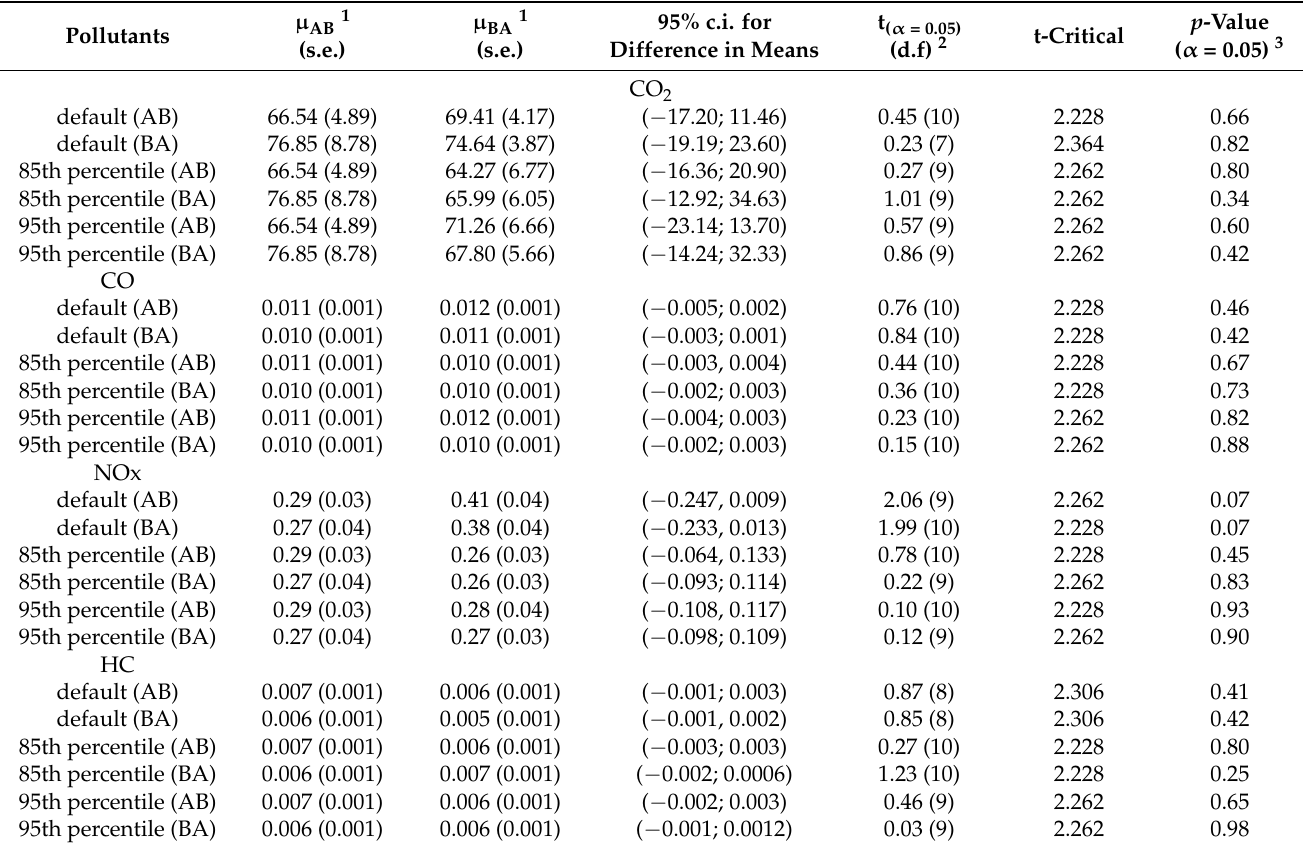
Table 6. The results of the two-sample t -test for comparing average emissions between observed and simulated data (default, 85th and 95th) by pollutant and by driving direction AB and